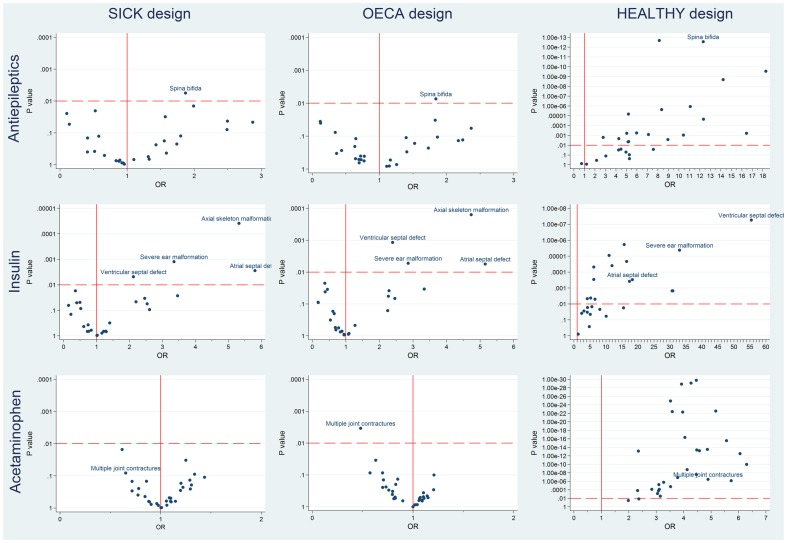
Associations between medications and birth defects for SICK, OECA and HEALTHY designs.The smile plots summarize the associations between each birth defect and exposure to antiepileptics, insulin, and acetaminophen for the three case-control designs. In each smile plot, P-values are plotted on the y-axis on a reverse log scale against the estimated odds ratios on the x-axis. So, the higher the P-values up the y-axis the more significant they are. The vertical full red line represents no association between medication exposure and birth defect (OR equals to 1), and the horizontal dashed red line represents the cut-off P value (0.01).